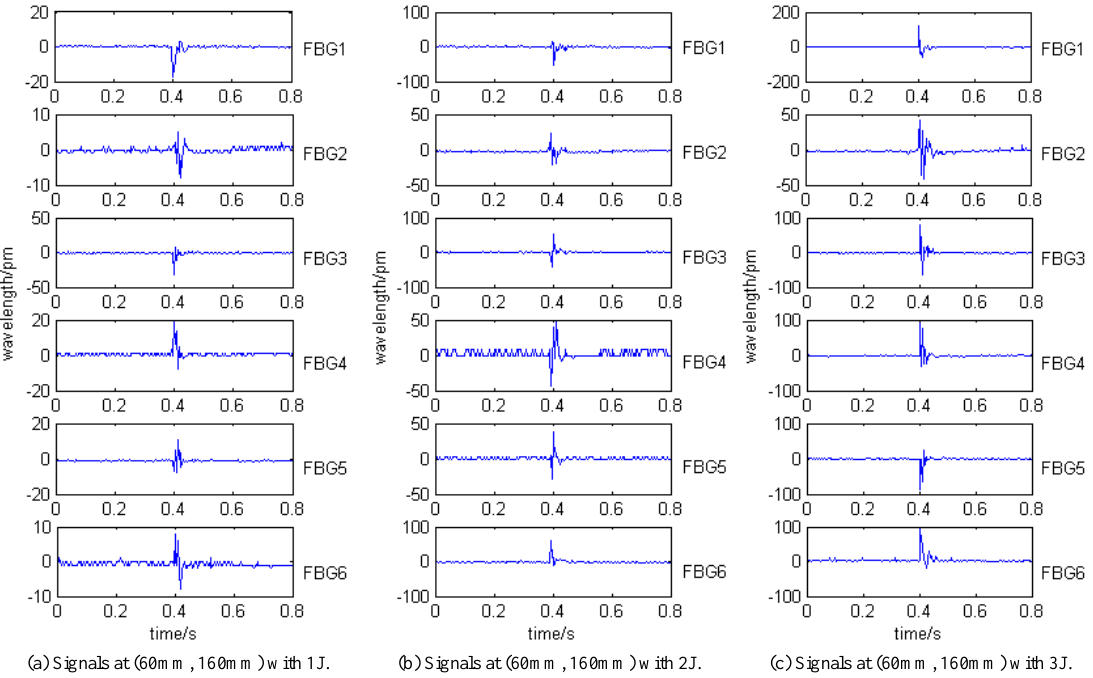
Figure 5. Sensing network signals at impact point (60 mm, 160 mm) with 1 J, 2 J, 3